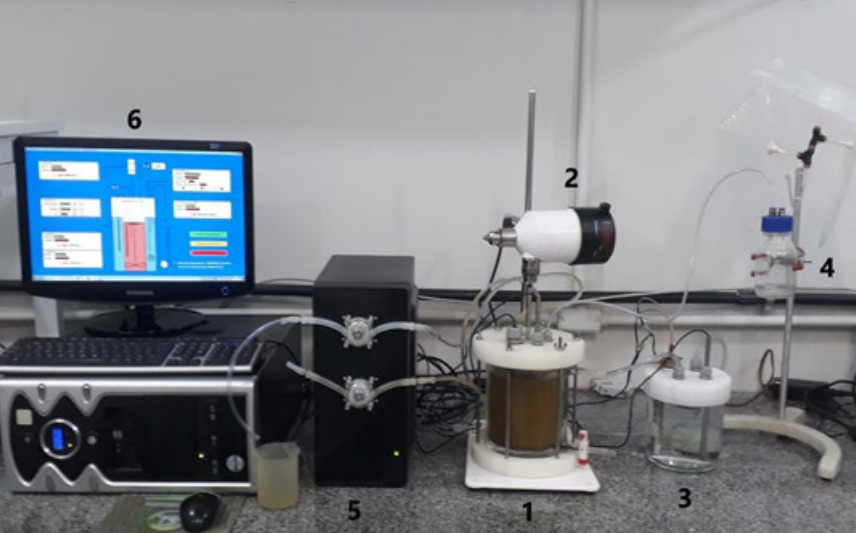
Figure 6. Operability and efficiency experiments in built biodigesters. (1) Bioreactor, (2) Stirring system, (3) Heating system, (4) Biogas collection and storage system, (5) control and automation unit and (6) Supervisory software.